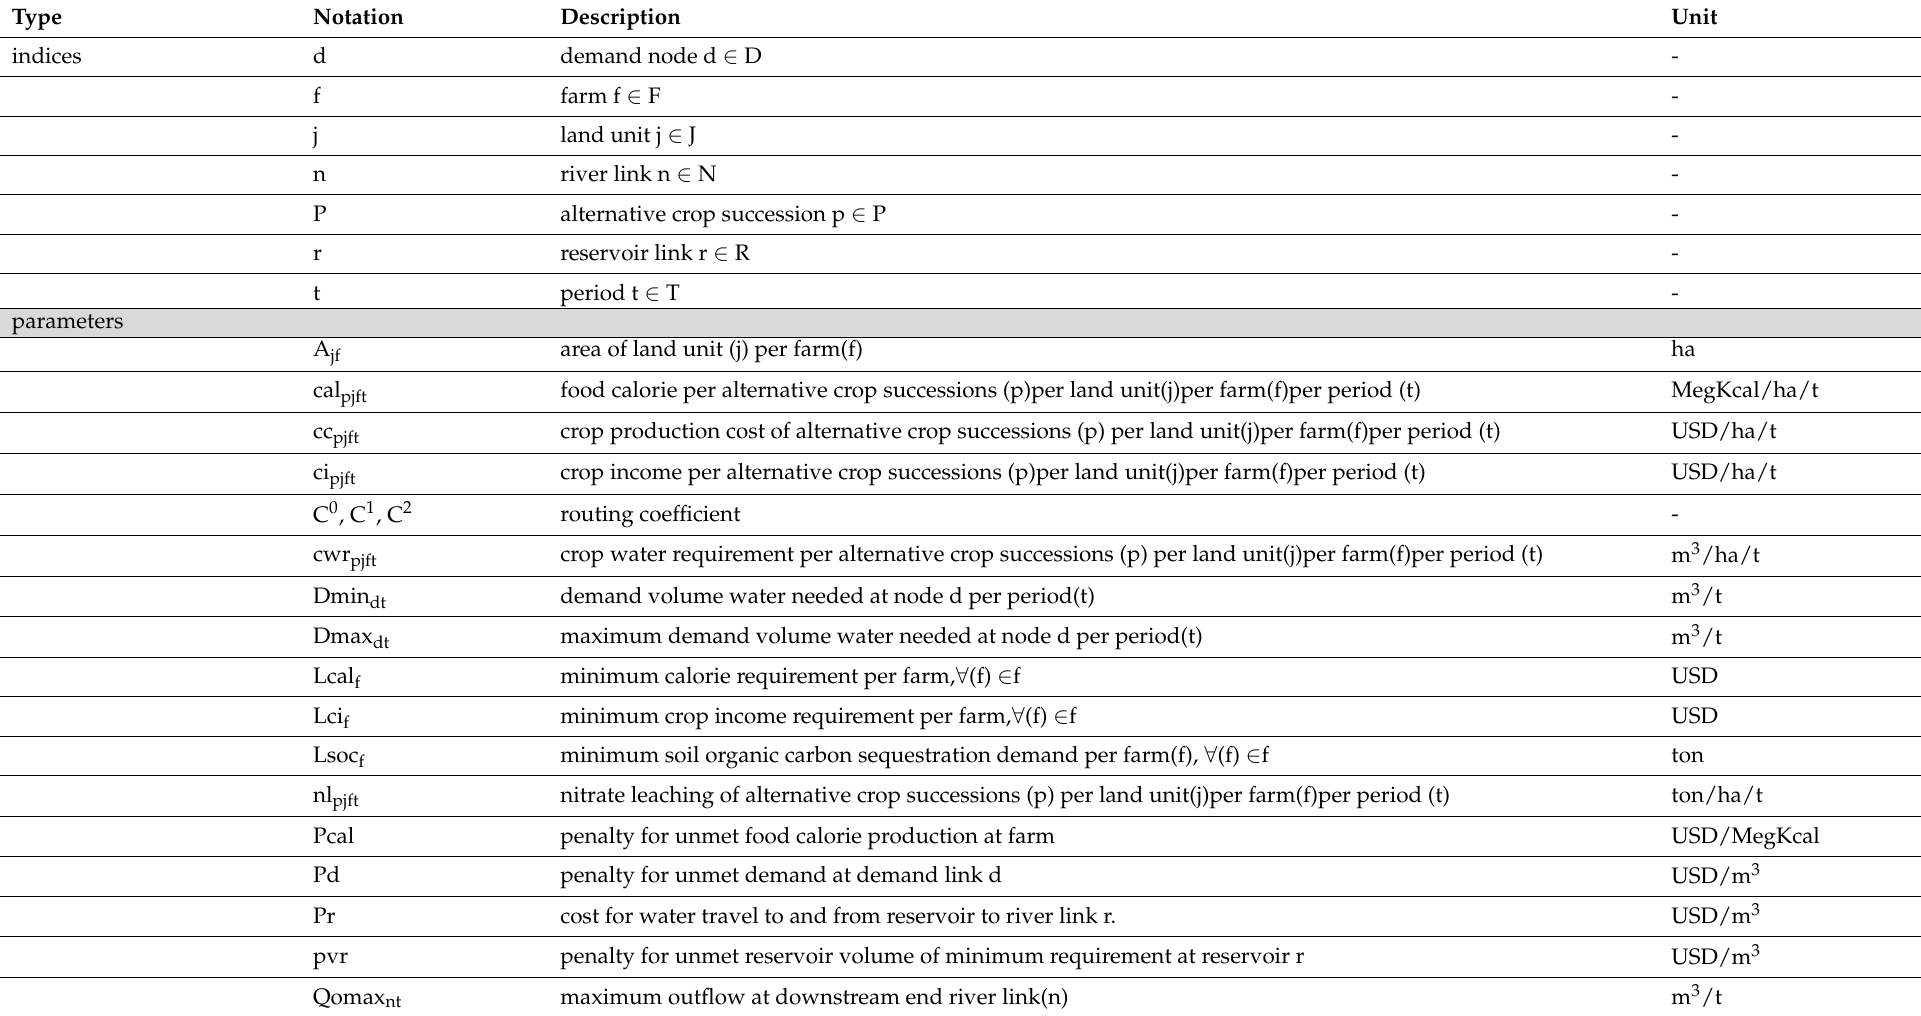
Table 2. Indices, parameters, and variables used in the